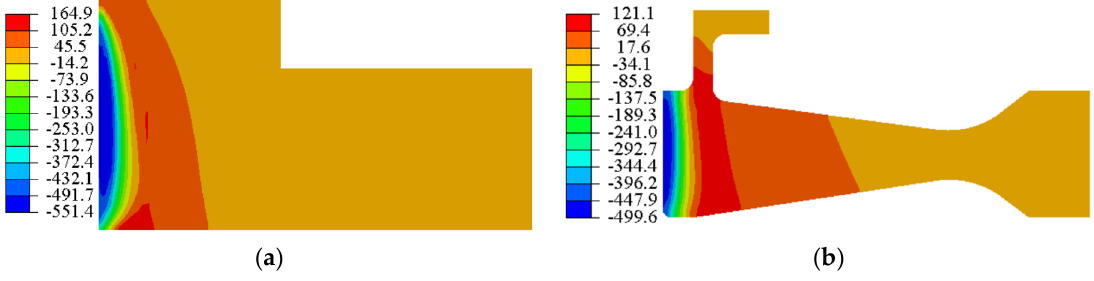
Figure 8. Residual hoop stress after AJC. ( a ) Rough machined workpiece ( b ) Finishing disc.